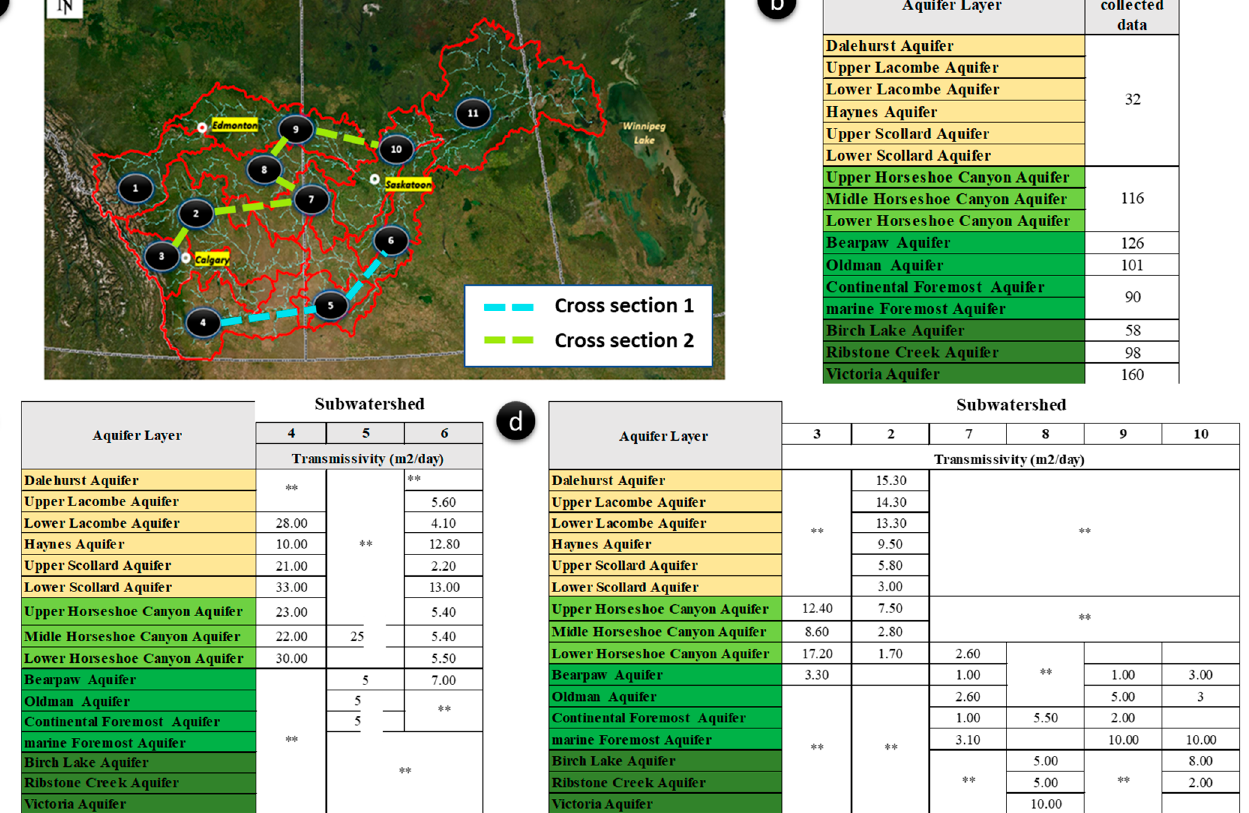
Figure 5. Mean transmissivity values of aquifer layers: ( a ) position of cross-sections, ( b ) several transmissivity values that were collected for each aquifer layer, ( c ) mean transmissivity values of aquifer layers along cross-section 1, and ( d ) average transmissivity values of aquifer layers along cross-section 2. ** = uncaptured aquifer.